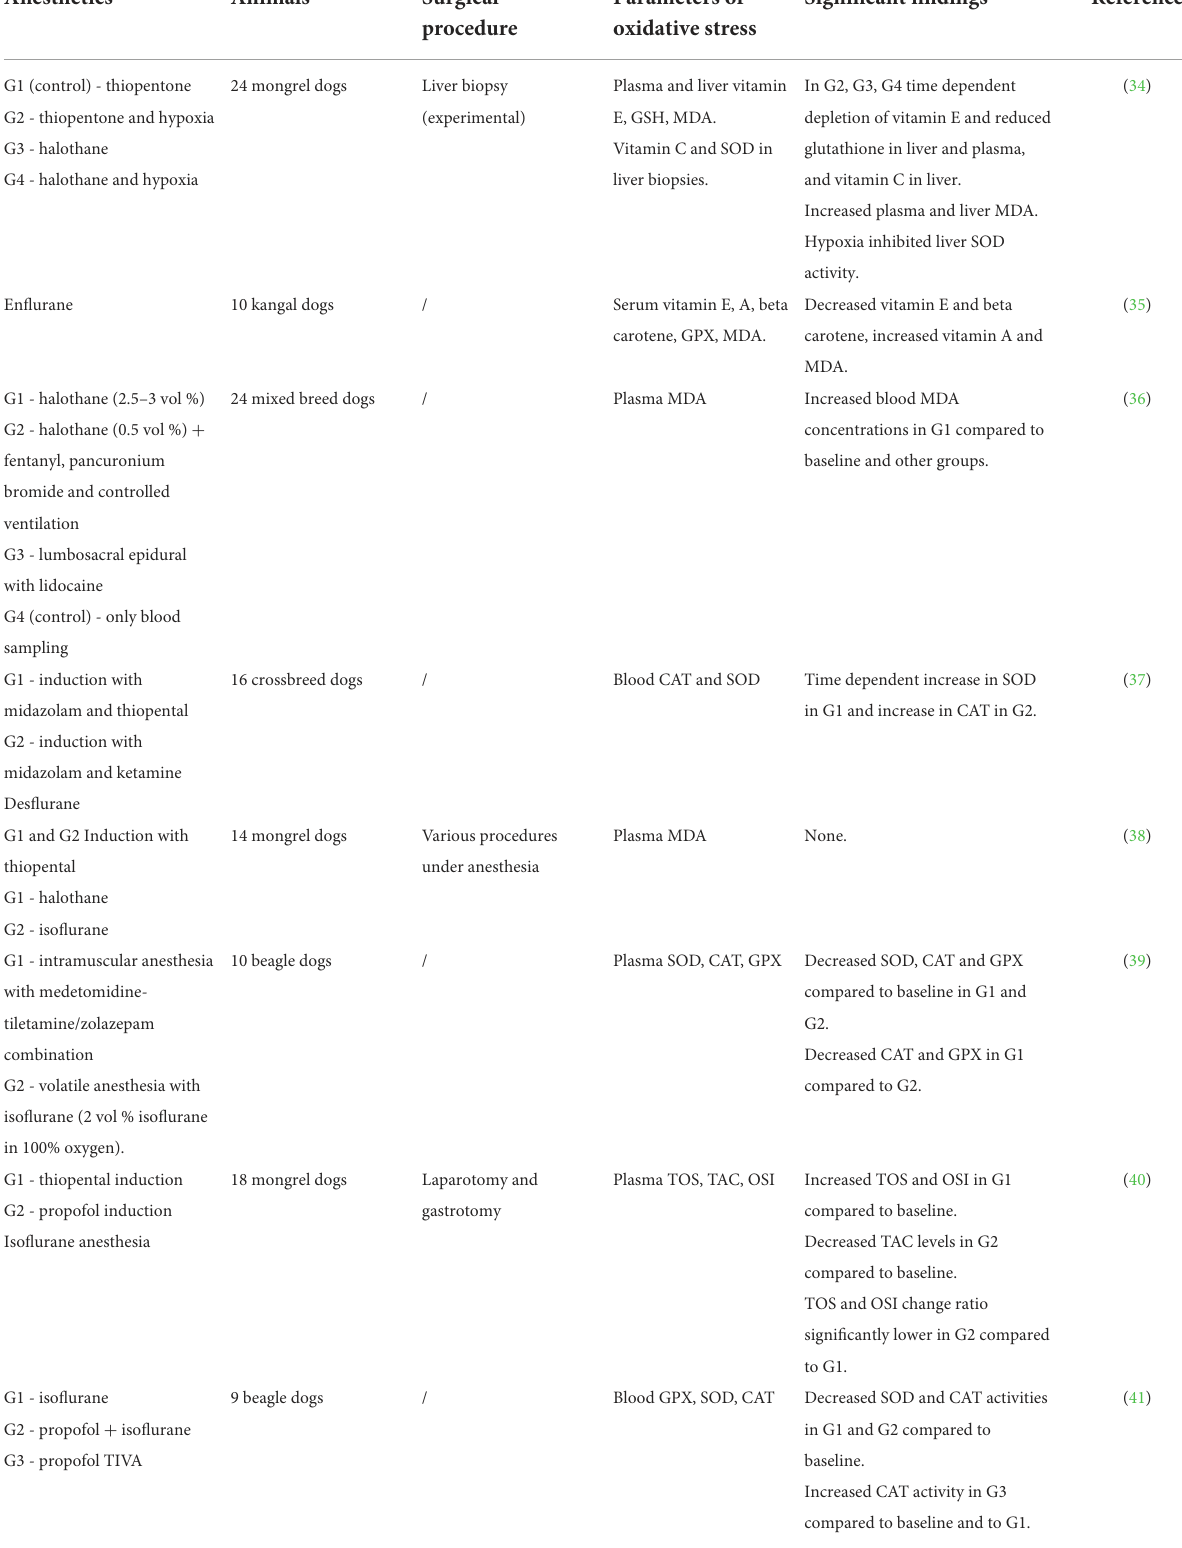
TABLE 1 Clinical studies and results on oxidative stress during anesthesia in dogs. Anesthetics Animals Surgical